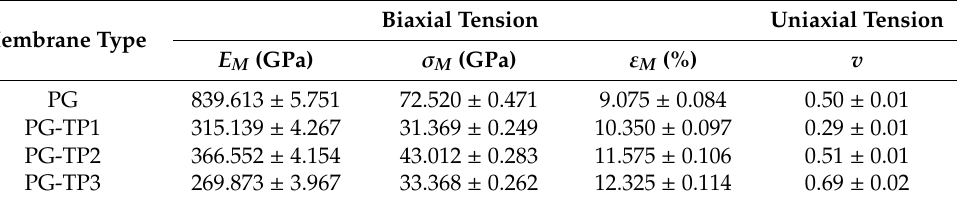
Figure 3. Stress–strain curves obtained from biaxial tensile tests.